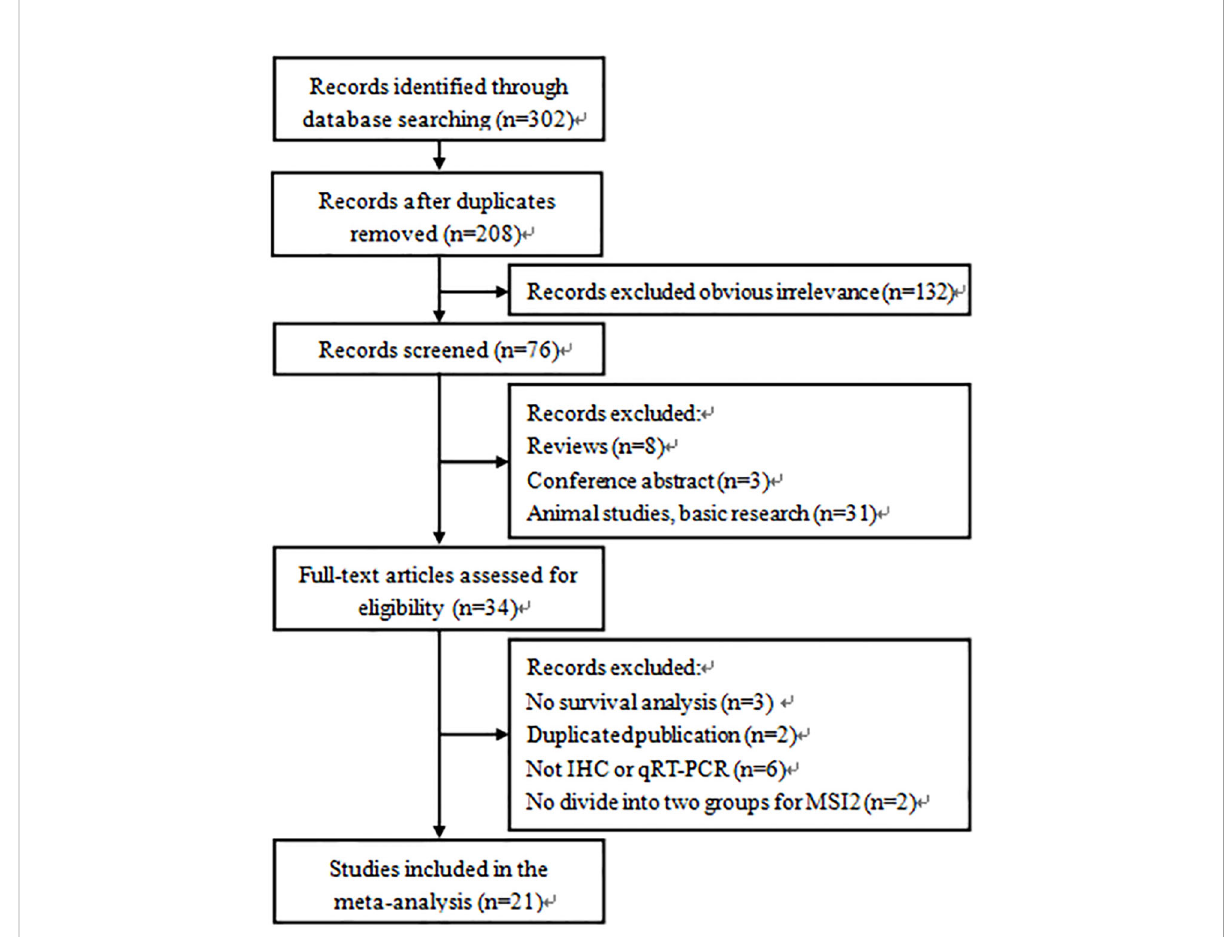
FIGURE 1 Flow diagram of the study selection process and speci fi c reasons for exclusion of the studies in the